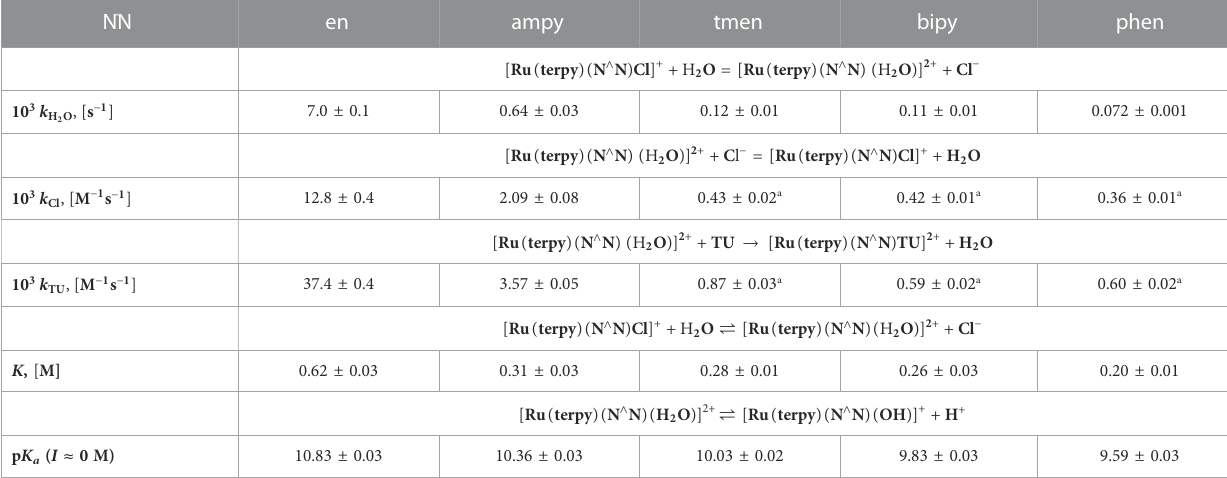
TABLE 1 Values of k H for [Ru (terpy) (N ∧ N)Cl] + complexes, k Cl , k TU , and p K a of [Ru (terpy) (N ∧ N) (H 2 O)] 2+ complexes, and equilibrium constants K (= k H 2 O 25 ° C (Chrzanowska et al., 2017; Chrzanowska et al., 2018; Chrzanowska et al., 2020b; Hubbard et al., 2020).